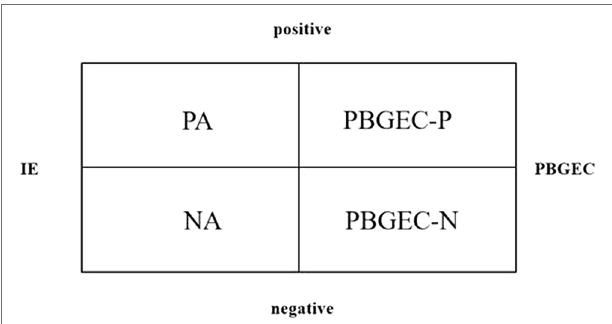
FIGURE 1 | Four-factor